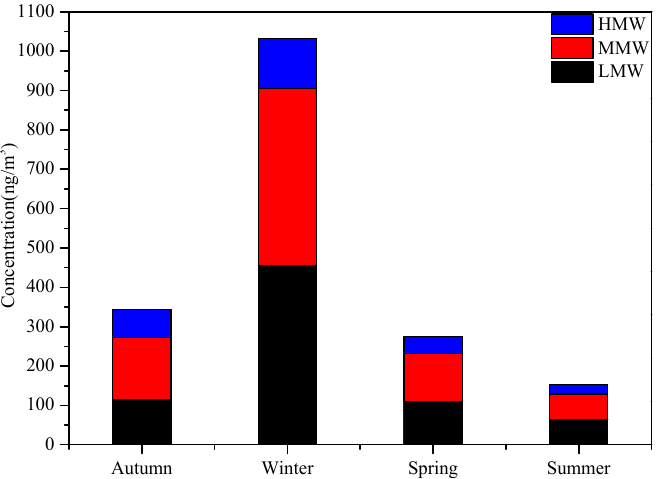
Figure 8. Seasonal variation of different PAHs at sampling sites in Urumqi. After analysis, the average annual mass concentration of Σ PAHs was 451.35 ng/m 3 , which was higher than the concentration of polycyclic aromatic hydrocarbons in Urumqi in 2010 (303.37 ng/m 3 ) [7]. The highest mean value of the mass concentration of Σ PAHs in winter was 1032.66ng/m 3 , which is about 6.7 times that in summer (153.72 ng/m 3 ). It was higher than the values in winter in Lanzhou [39] in 2013 (302 ng/m 3 ) and winter in Beijing [40] in 2014 (63.88 ng/m 3 ). Wang et al. [41] showed that the seasonal variation of PAHs was related to local meteorological conditions. Environmental